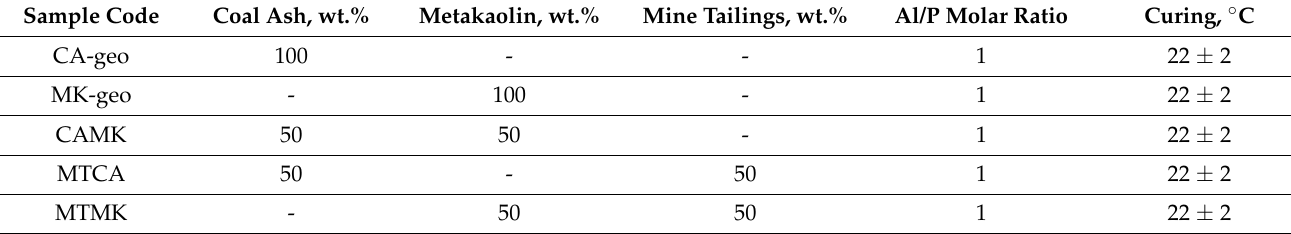
Table 2. Mix design and